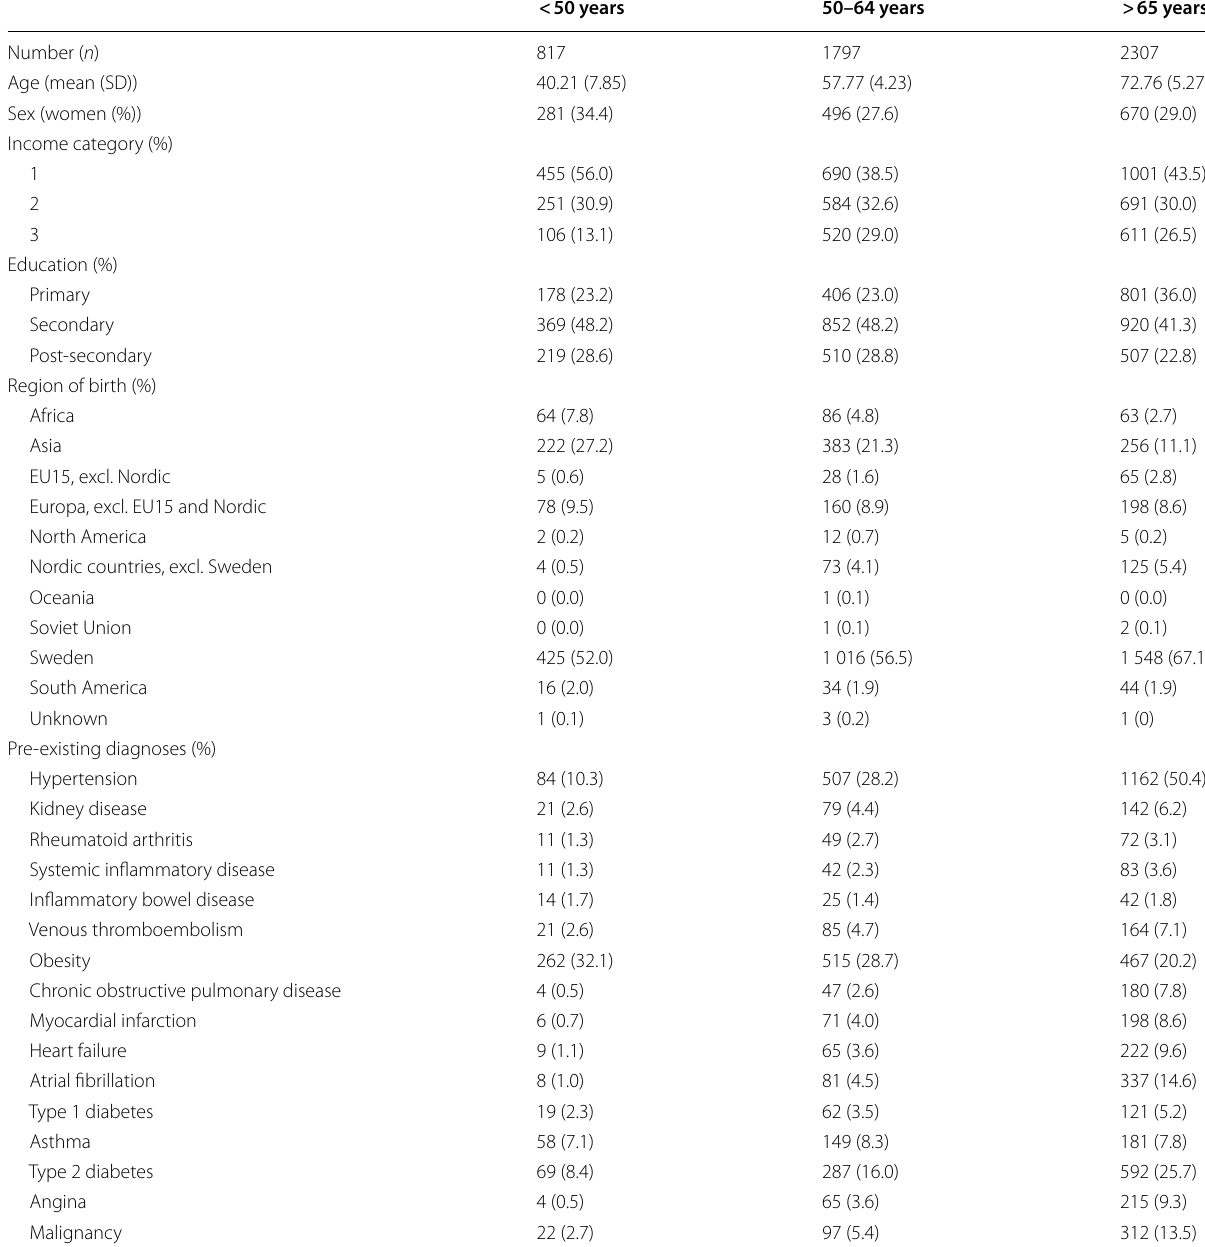
Table 2 General characteristics of cases at ICU